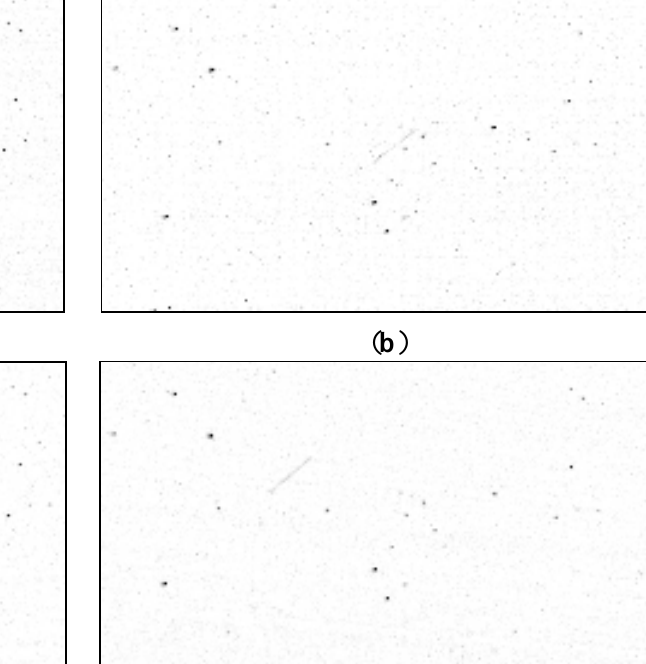
Figure 6. Warping: aligning the star background between the images of the stereo pair. Left ( a ) and right ( b ) original images, cropped. Warped right image to match the stars of the original left image ( c ), and warped left image to match the stars of the right image ( d